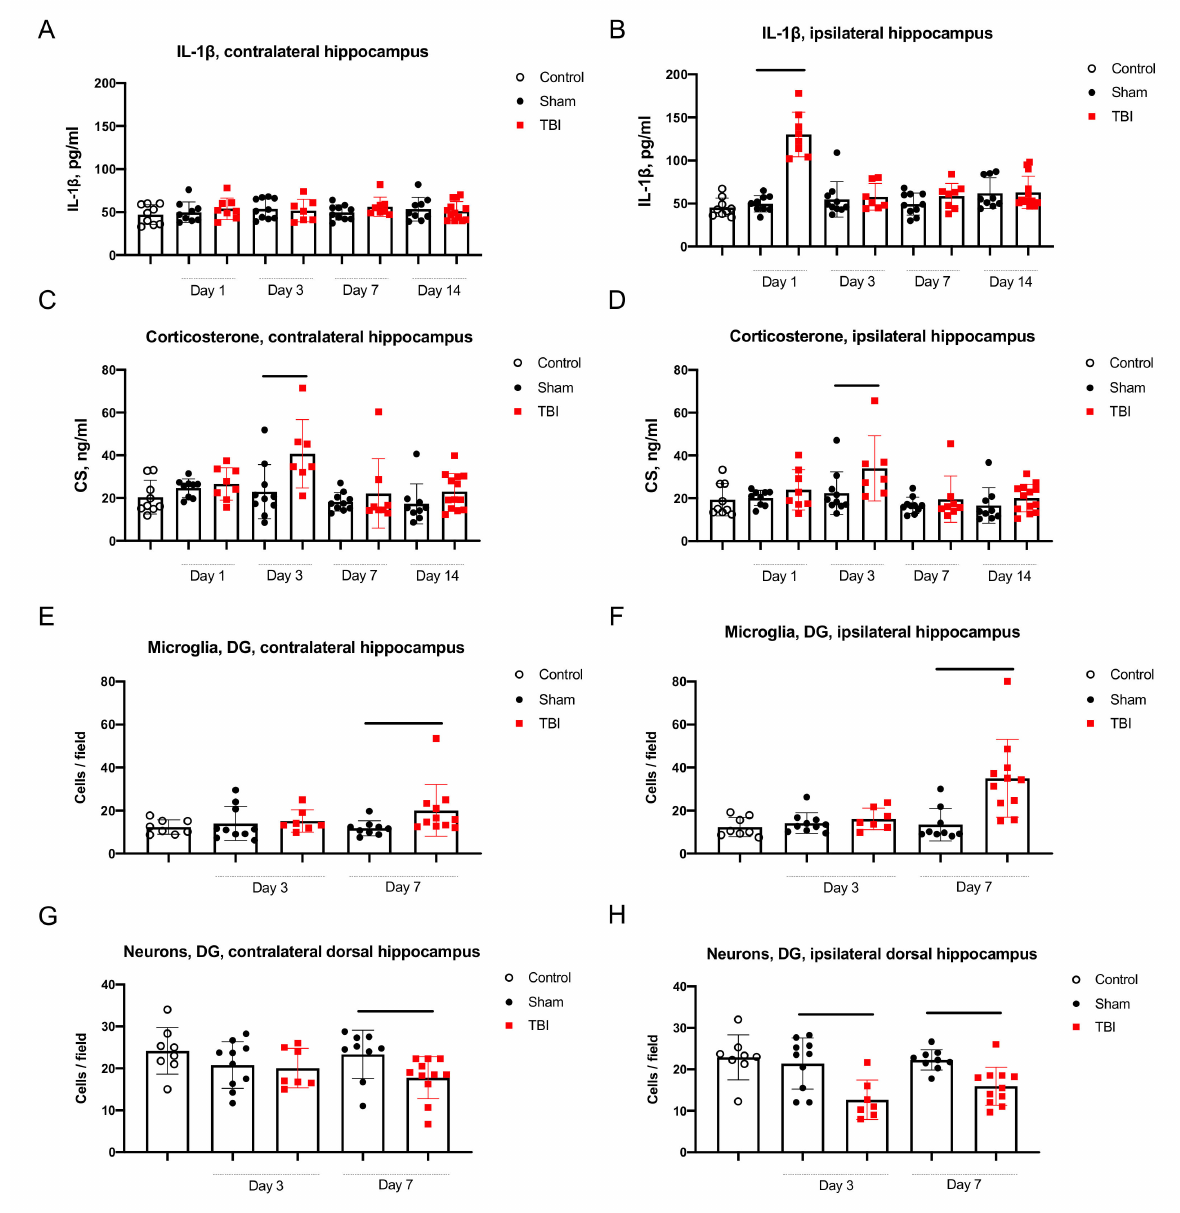
Figure 2. Neuroinflammation and neurodegeneration in the hippocampus. ( A , B )—elevated IL-1 β in the ipsilateral hippocampus on day 1 after TBI. ( C , D )—Elevated CS in the ipsilateral and contralateral hippocampus on day 3 after TBI. ( E , F )—Elevated microglial cell count in the hippocampus on day 7 in the ipsilateral and contralateral hippocampal DG. ( G , H )—Decreased neuronal cell count in the ipsilateral hippocampal DG on day 3 and in the contralateral hippocampal DG on day 7 after TBI. p < 0.05, Mann-Whitney